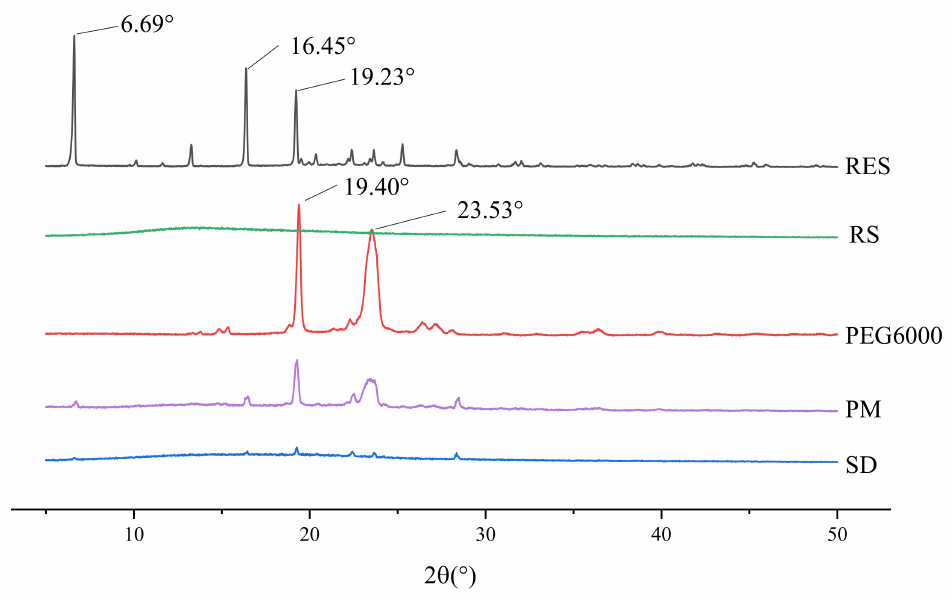
Figure 12. XRD spectrum of RES, carriers, PM, and RES/RS/PEG6000-SRSD.